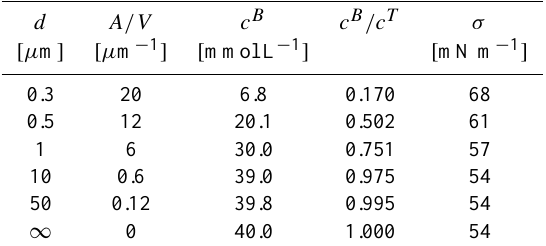
Table A1. Surfactant bulk molarities ( c B ), ratio of surfactant bulk and total ( c T ) molarities, and droplet surface tension, σ = σ(c B ) , for droplets of different diameters ( d ) created from the same c T = 40mmolL − 1 sodium decanoate (C10Na) solution. Surfactant sur- face excess is fixed to 0 = 10 18 m − 2 for all droplet sizes.